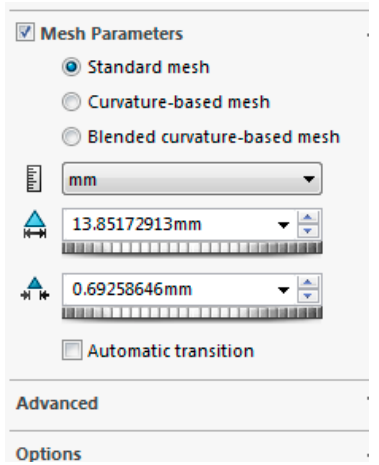
Figure 50. Steady-state Mesh Configuration.